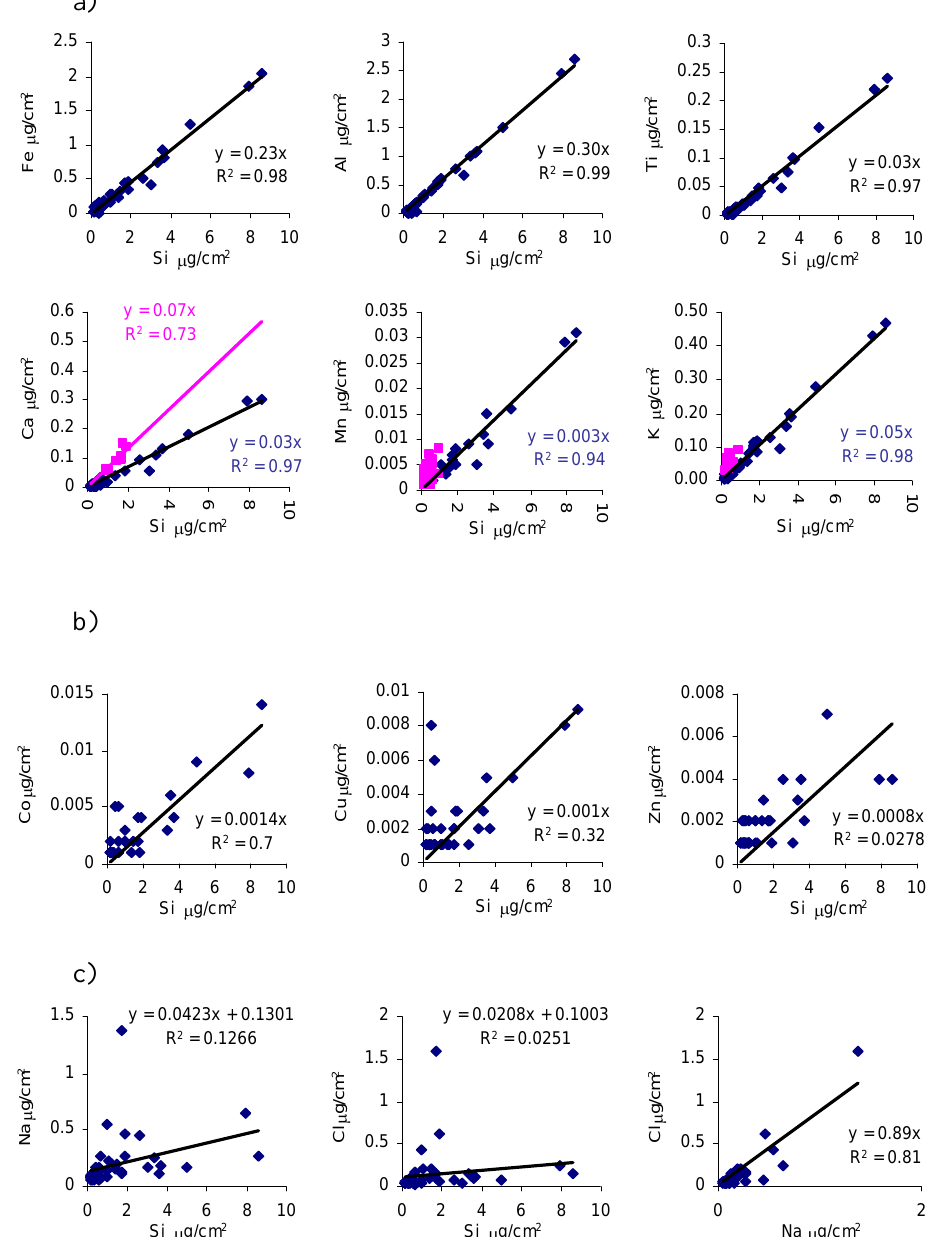
Fig. 9. (a) Scatter plots of Fe, Ti, Al, Ca, Mn and K against Si. (b) Scatter plots of Co, Cu and Zn against Si. (c) Scatter plots of Na and Cl against Si, and Cl against